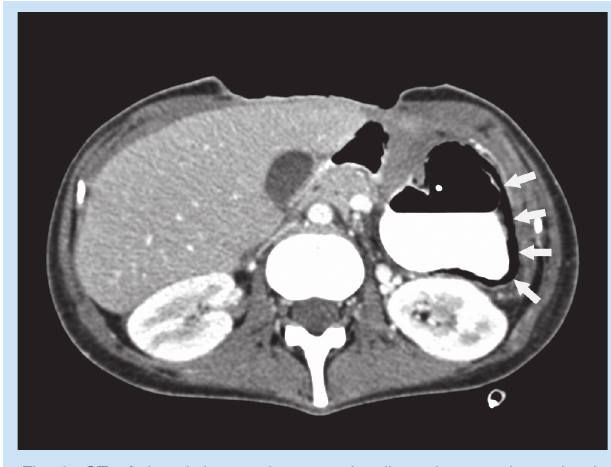
Fig. 3. CT of the abdomen demonstrating linear intramural gastric air